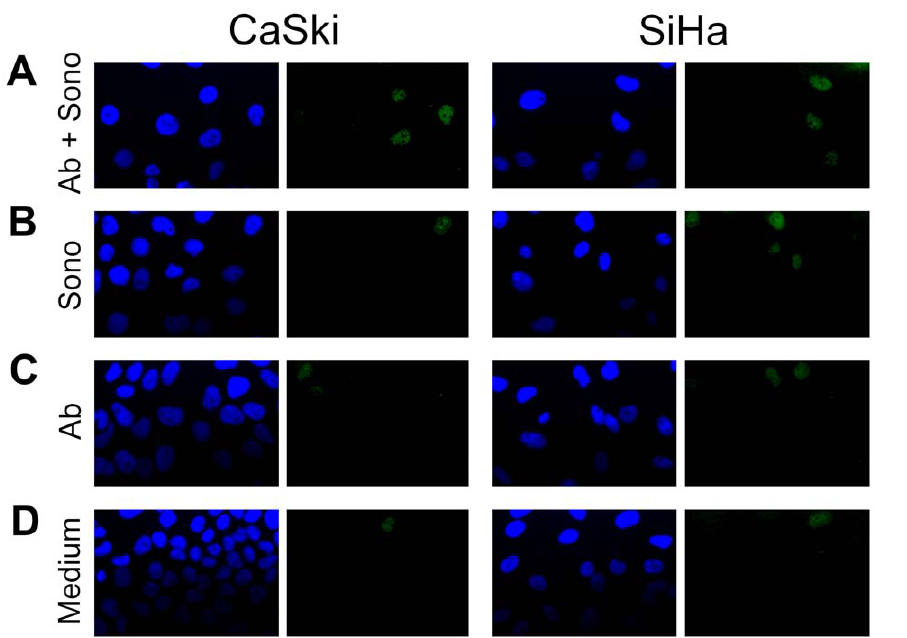
Figure 9. Immunofluorescence staining demonstrating p53 expression (green) following sonoporation treatment of the cells. (A) Treatment with 4 m g/mL F127-6G6 E6 antibody + sonoporation. (B) Treatment with no antibody + sonoporation. (C) Treatment with 4 m g/mL F127-6G6 E6 antibody-no sonoporation. (D) Treatment with no antibody-no sonoporation. Nuclei were counterstained blue with DAPI. Cells were visualized using 400 6 magnification 48 hours following sonoporation.